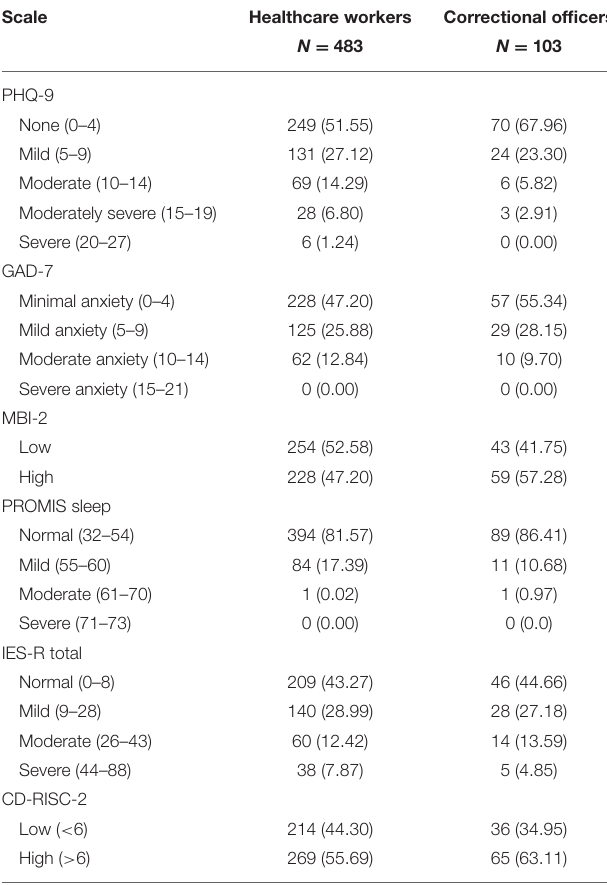
TABLE 1 | Demographic characteristics of participants ( N = 589). TABLE 2 | Categorized scores on mental health measures for health care workers and correctional officers.